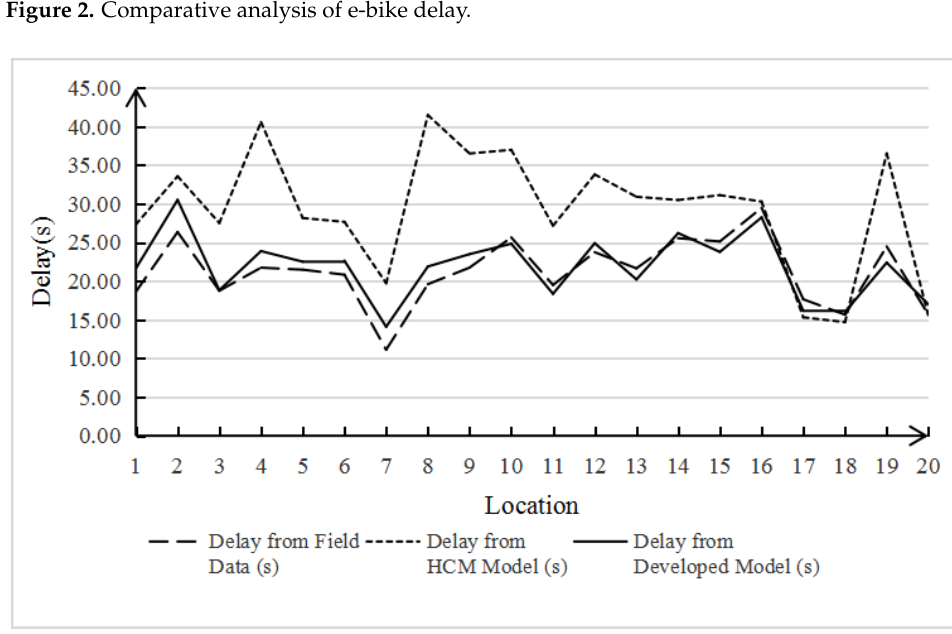
Figure 3. Comparative analysis of bicycle delay.